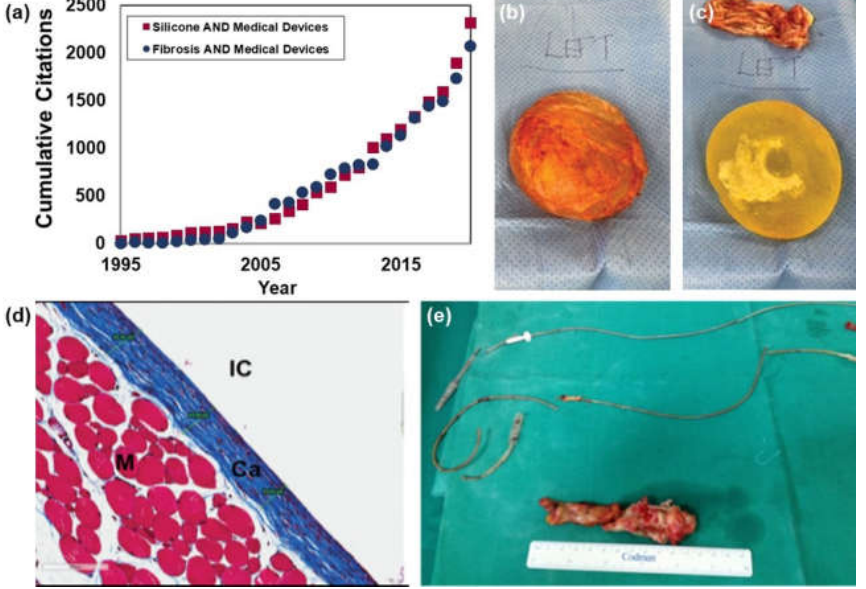
Figure 6. Fibrotic response to implantable devices. ( a ) A Web of Science citation analysis shows that as publications of Silicone Medical Devices were rising in number, so too were citations of work on Fibrosis and Medical Devices. This trend highlights a need to address the fibrosis in the medical device industry. ( b , c ) Silicone breast implants are commonly removed due to fibrotic layer development. ( d ) Masson’s trichrome staining on the surface of a silicone implant shows the collagenous layer (Ca, blue) that builds up around the implant (IC) surface. ( e ) Metallic implants such as cardiac pacemaker leads are also subject to the same fibrotic development that inhibits proper function of the device and necessitates removal. (Image ( b , c ) adapted from Lee et al. 2020 [130,131], image ( d ) adapted from Frenkiel et al. 2017 [132], image ( e ) adapted from Kokotsakis et al. 2014 [133] http://creativecommons.org/licenses/by/4.0/ (accessed on 1 December 2021)). It is critical to control the interactions between implanted materials and soft